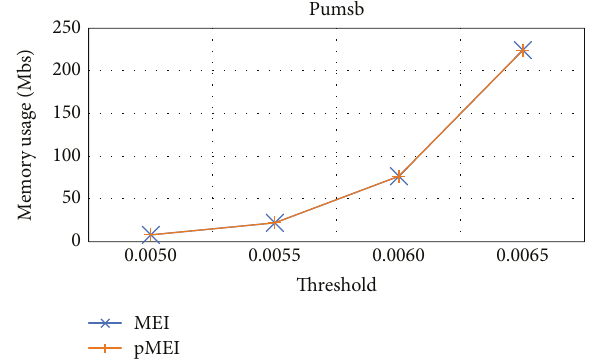
Figure 9: Memory usage of the MEI and pMEI methods on the Chess.